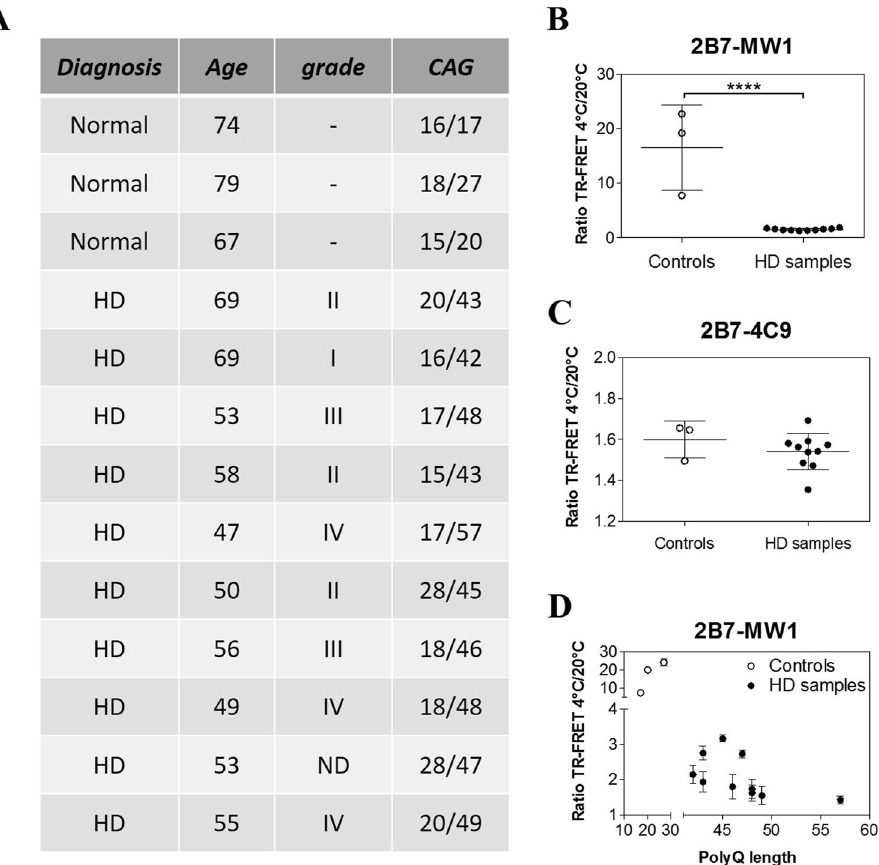
Figure 8. The 2B7/MW1 conformational immunoassay detects mHTT conformation in homogenates of control and HD post-mortem human brains (cortex). ( A ) Table illustrating the salient features of human control and HD donors of samples for this study. ( B ) Summary of 2B7/MW1 conformational immunoassay data (ratio TR-FRET signals at 4 °C/20 °C) obtained on homogenates of control and HD brain samples. ( C ) Summary of 2B7/4C9 control immunoassay data (ratio TR-FRET signals at 4 °C/20 °C) obtained on the same homogenates of control and HD brain samples. ( D ) Same as A, plotted against CAG (polyQ) repeat length rather than against control/HD genotype. In B and C values represent means and standard deviations of the means of three independent experiments (Datasets were tested for normality and Student’s t-test, degrees of significance are indicated). Signals obtained from TR-FRET immunoassays, preparatory for the conformational analysis, are reported in Supplementary Information: Figure